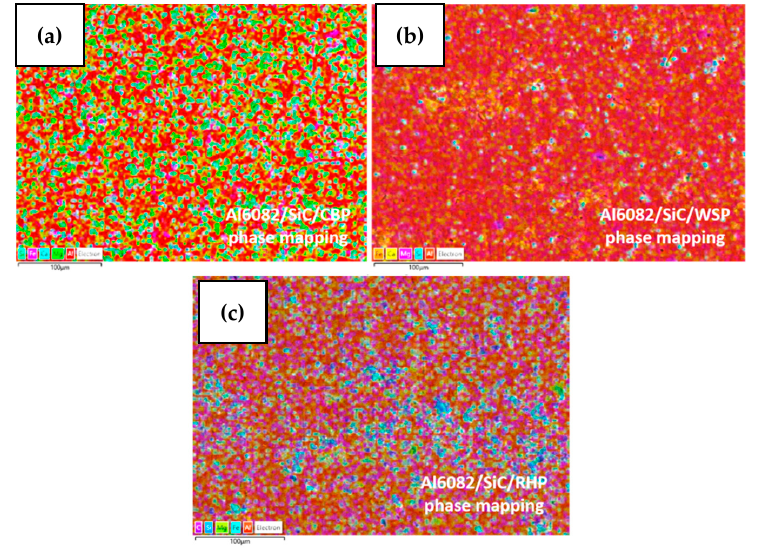
Figure 5. EDS phase mapping; ( a ) Al6082/2% SiC/2%CBP, ( b ) Al6082/2% SiC/2%WSP, ( c ) Al6082/2% SiC/2%RHP.